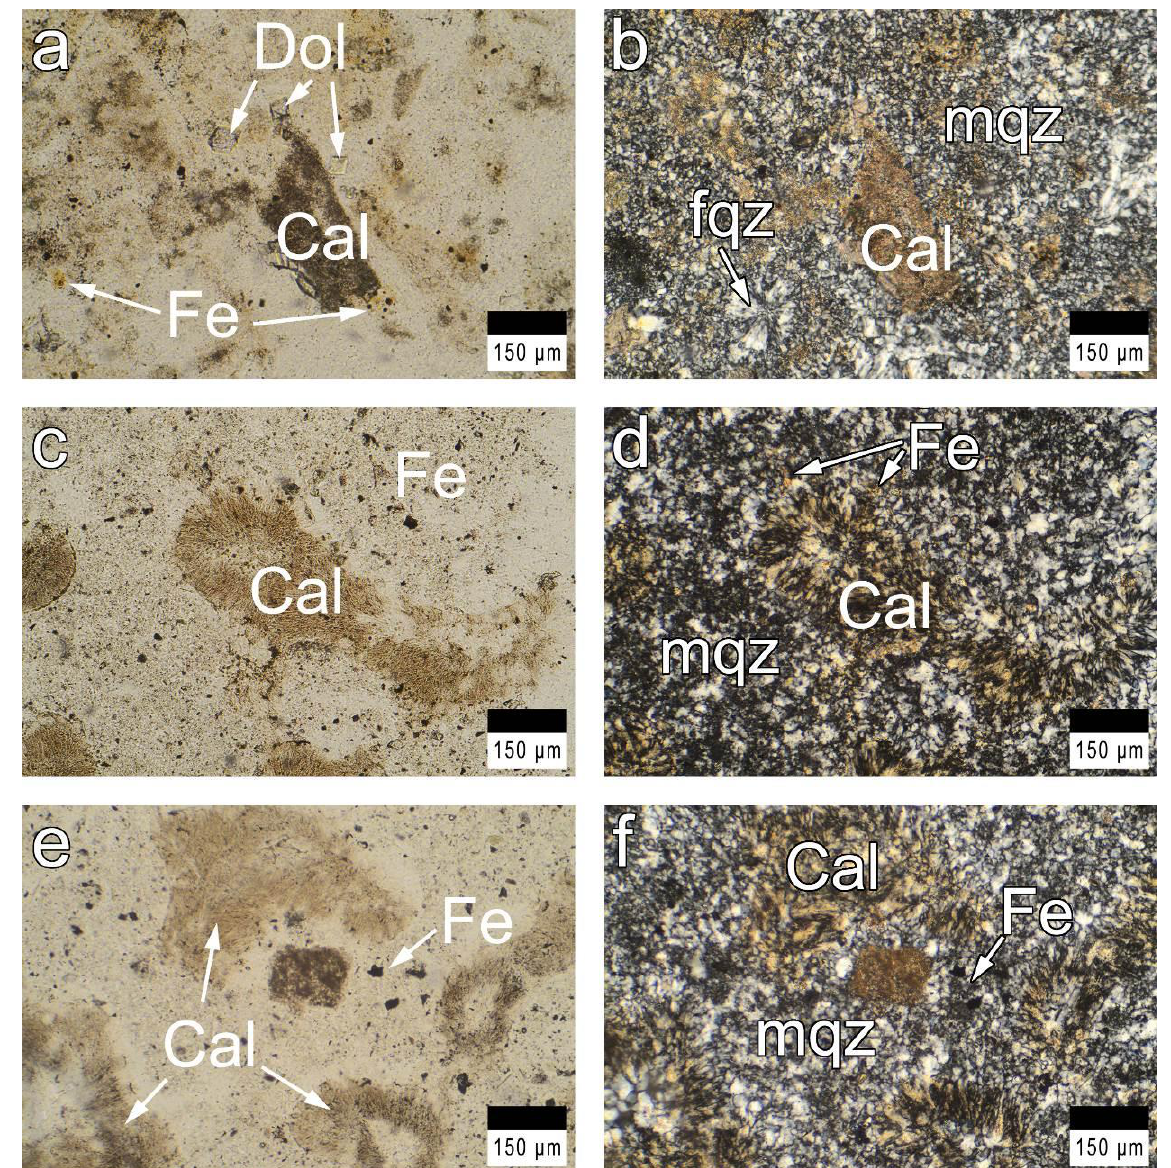
Figure 13. Microphotos (polarized light) of chert from Răcătău-Piatra Tomii. a) to f) Well developed microcrystalline quartz mixed with calcite and with small clusters of fibrous microquartz. Fe compounds are restricted to small areas. Left side, one polarizer (1P). Right side, the same with crossed polarizers (+P). Abbreviations: mqz for microgranular quartz, fqz for fibrous quartz, Cal for calcite, Fe for iron phase, Dol for